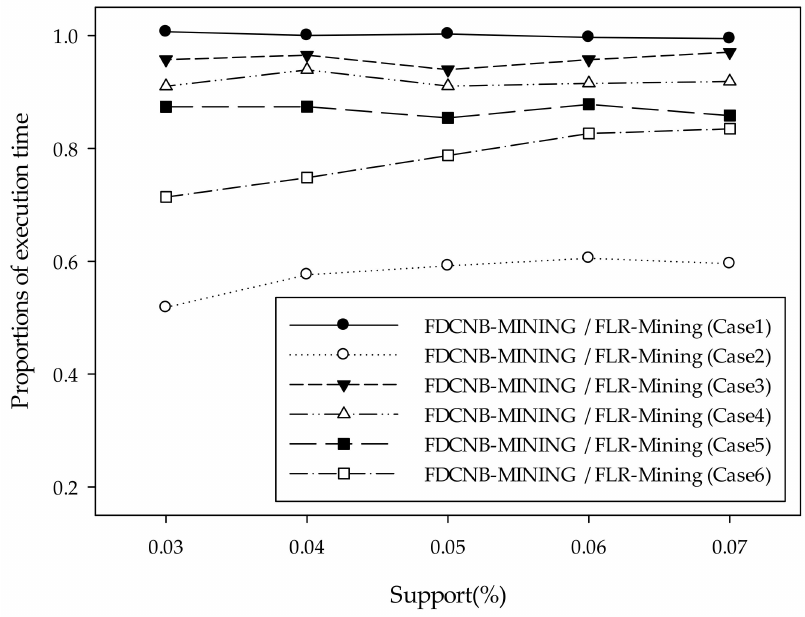
Figure 2. E ff ect of varying support from 0.03% to 0.07% on proportions of execution time in FDCNB- MINING and FLR-mining.